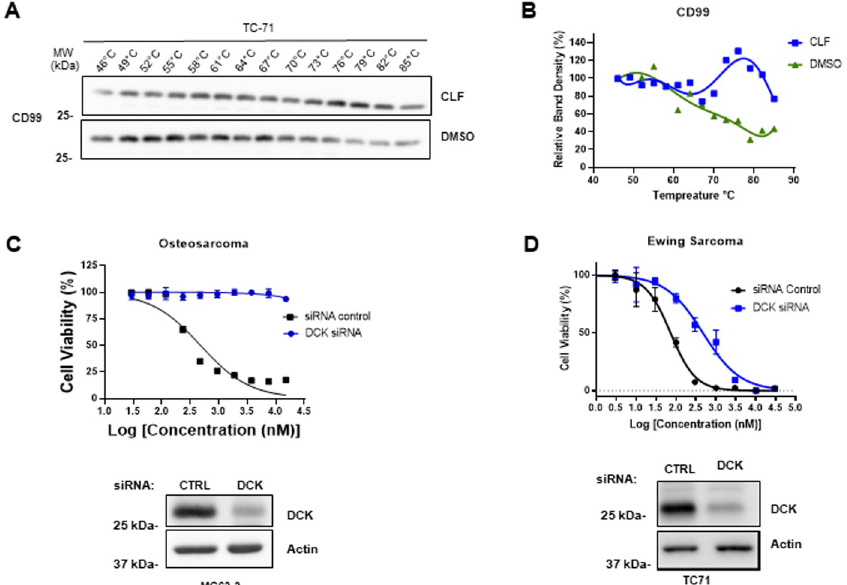
Fig 1. Clofarabine can bind CD99 and inhibit ES cell growth as a prodrug. (A) Thermal stability of CD99 protein was tested in the presence of clofarabine (CLF) by western blotting. CD99 stabilized by clofarabine stays in solution at higher temperatures; (B) Graph represents band density of CD99 from panel a. Densities of bands were measured with ImageJ and analysis was done using GraphPad Prism. (C, D) MG63.3 OS and TC-71 ES cell lines were transiently transfected with control (black lines) or DCK siRNA (blue lines). DCK protein expression was confirmed by western blot. Reduced DCK expression resulted in complete resistance to clofarabine in OS cells but not in ES